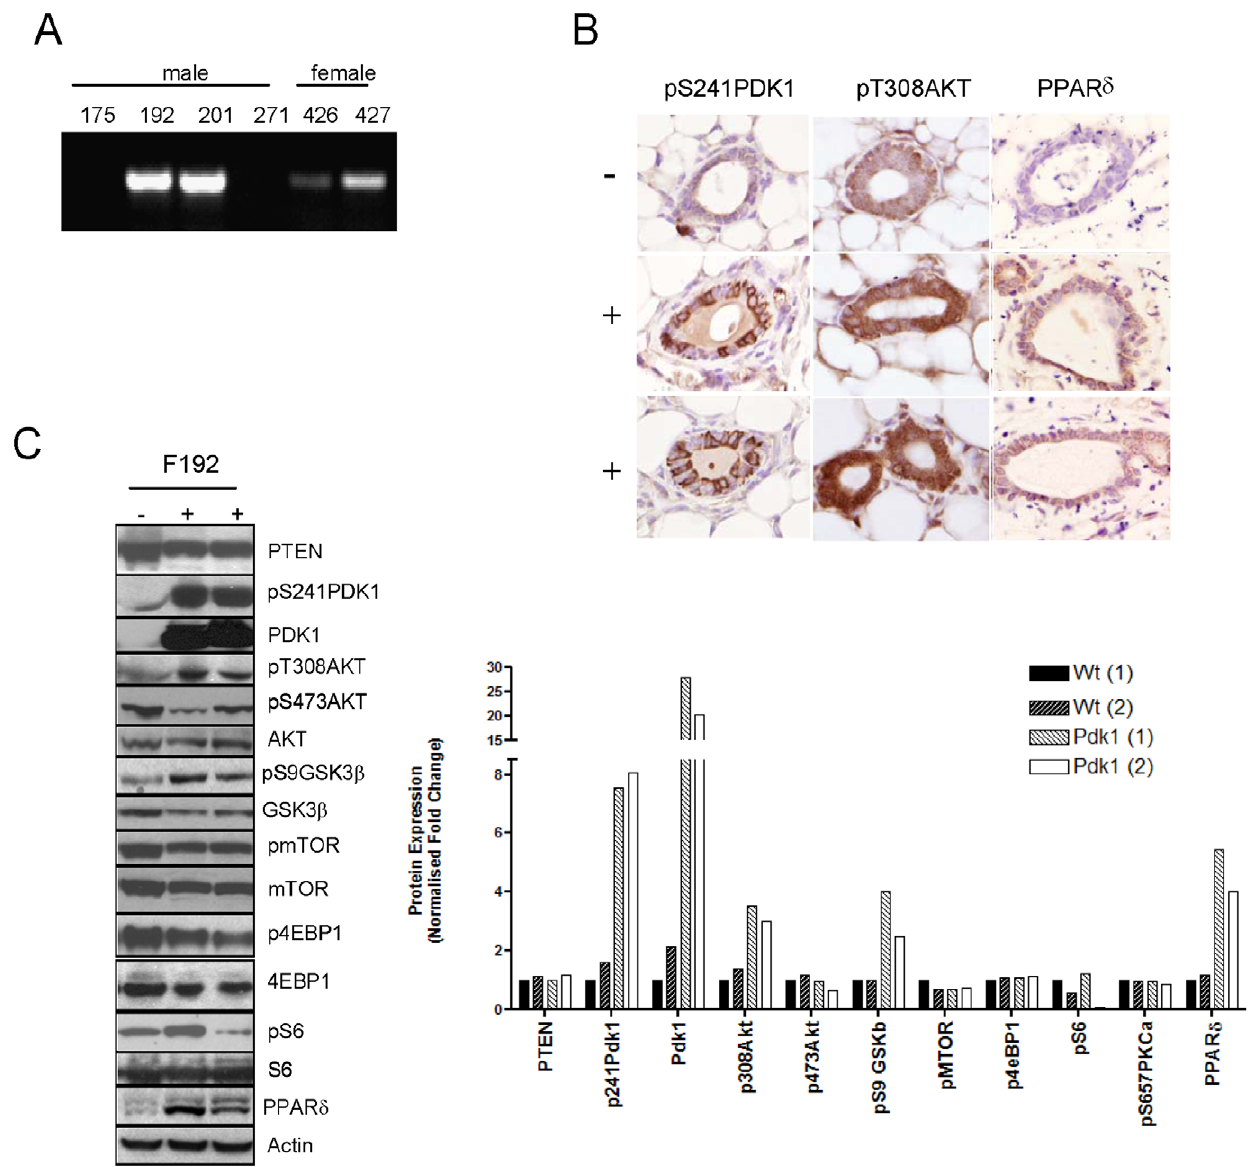
Figure 1. PDK1 transgene expression and analysis of downstream signaling. (A) PCR analysis. DNA was prepared from tail DNA and transgene expression analyzed by PCR using primers specific for the MMTV-PDK1 transgene. The results indicate that MMTV-PDK1 is expressed in four founder lines. (B) IHC analysis indicates that pS241PDK1, pT308AKT and PPAR d were increased in the mammary gland of two nulliparous MMTV-PDK1 mice ( + ) vs. a wild-type littermate ( 2 ) from founder line 192. Magnification 600 6 . (C) Western analysis. Mammary gland lysates from two 7 week-old nulliparous MMTV-PDK1 ( + ) mice and one wild-type ( 2 ) littermate derived from founder line 192 were analyzed by western blotting. Founder line 192 expressed increased pT308AKT, pS9GSK3 b and PPAR d . The bar graph represents quantitation of the western blots normalized to either non- phosphorylated protein or b actin levels.